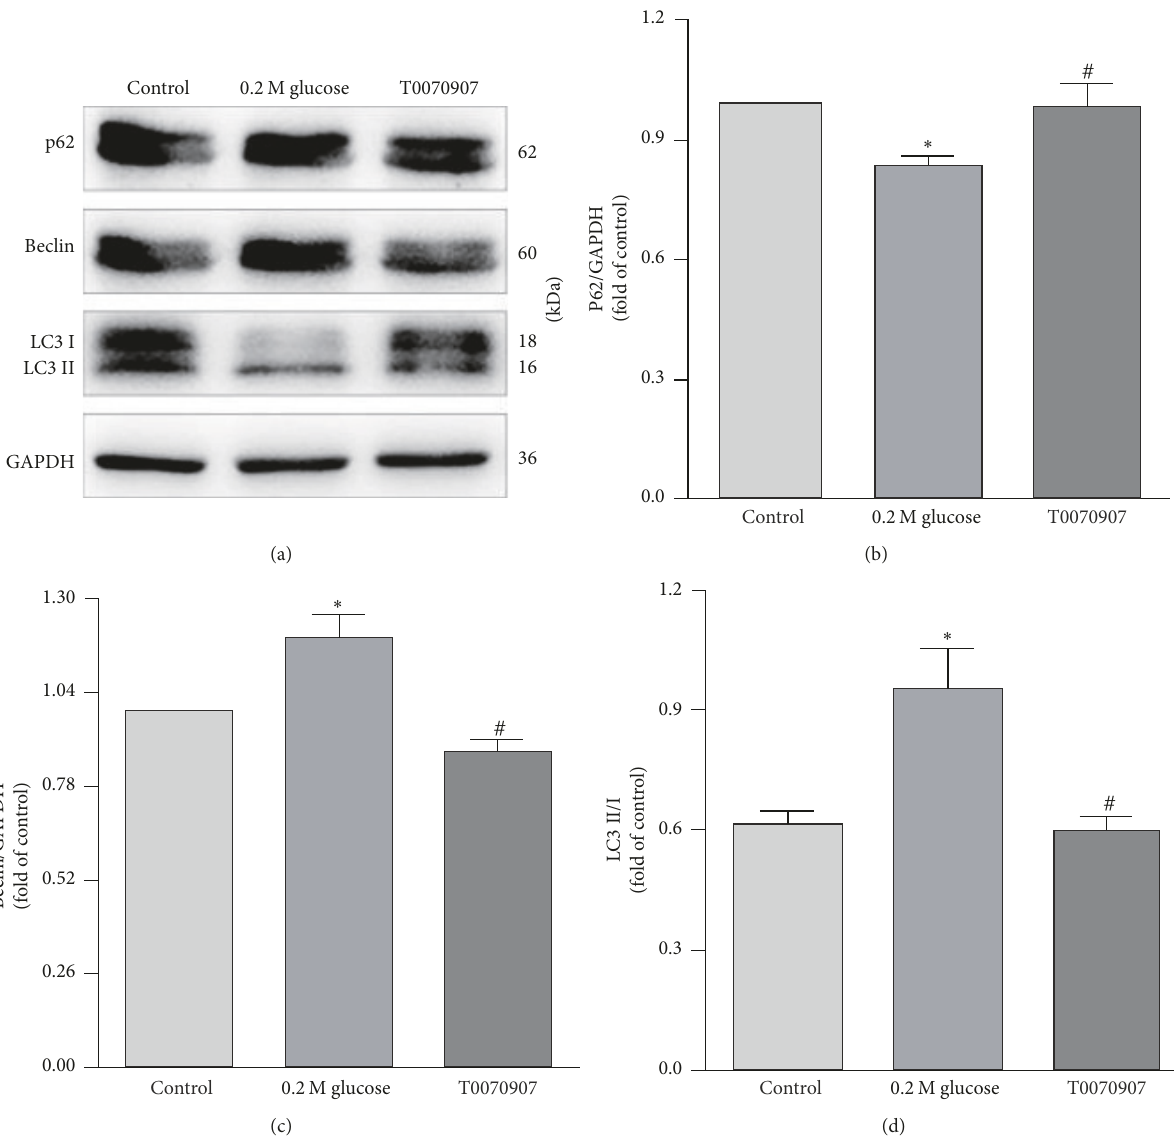
Figure 5: Western blot showed that the expression of Beclin-1 and LC3-II decreased and p62 increased in the NP cells when treated with PPAR 𝛾 antagonist. # represents a significant difference from 0.2 M high glucose condition (𝑝 < .05) .